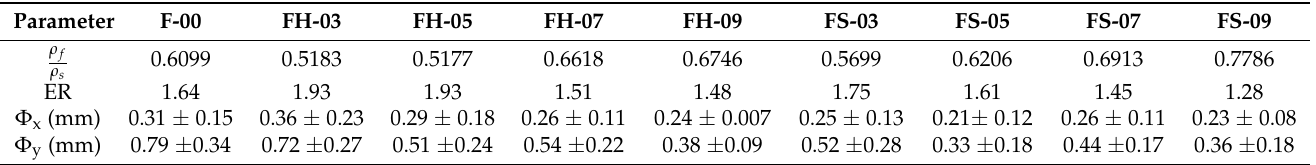
Table 7. Density and expansion ratio of NRF at various